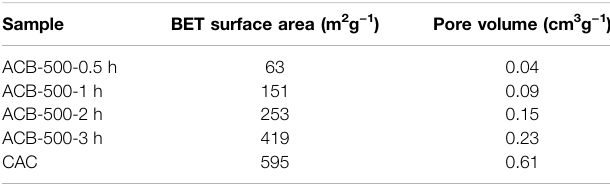
TABLE 5 | BET surface area and pore volume results for the activated bio-chars produced at 900 ° C with activation times of 0.5 – 3 h compared to commercial activated carbon (CAC).